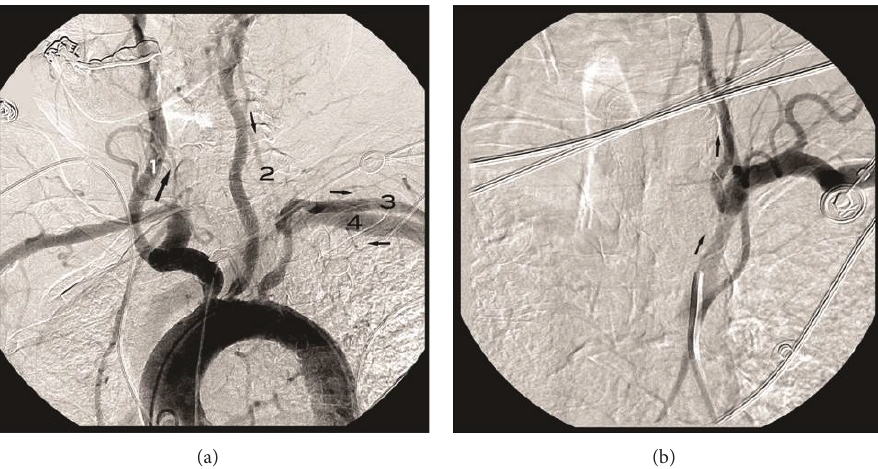
Figure 2: (a) Aortic arch angiogram demonstrating the overall hemodynamics. There is occlusion of the right VA origin and antegrade flow through the right common carotid artery (1) with reversal of flow in the left VA (2) down to the left subclavian artery (3). Note the early antegrade flow through the left subclavian artery (3) and the early filling of the left subclavian vein (4) indicative of the high flow through the dialysis AVF. (b) Anteroposterior left subclavian angiogram with occlusion of the AVF shows reestablishment of normal antegrade flow through the left vertebral